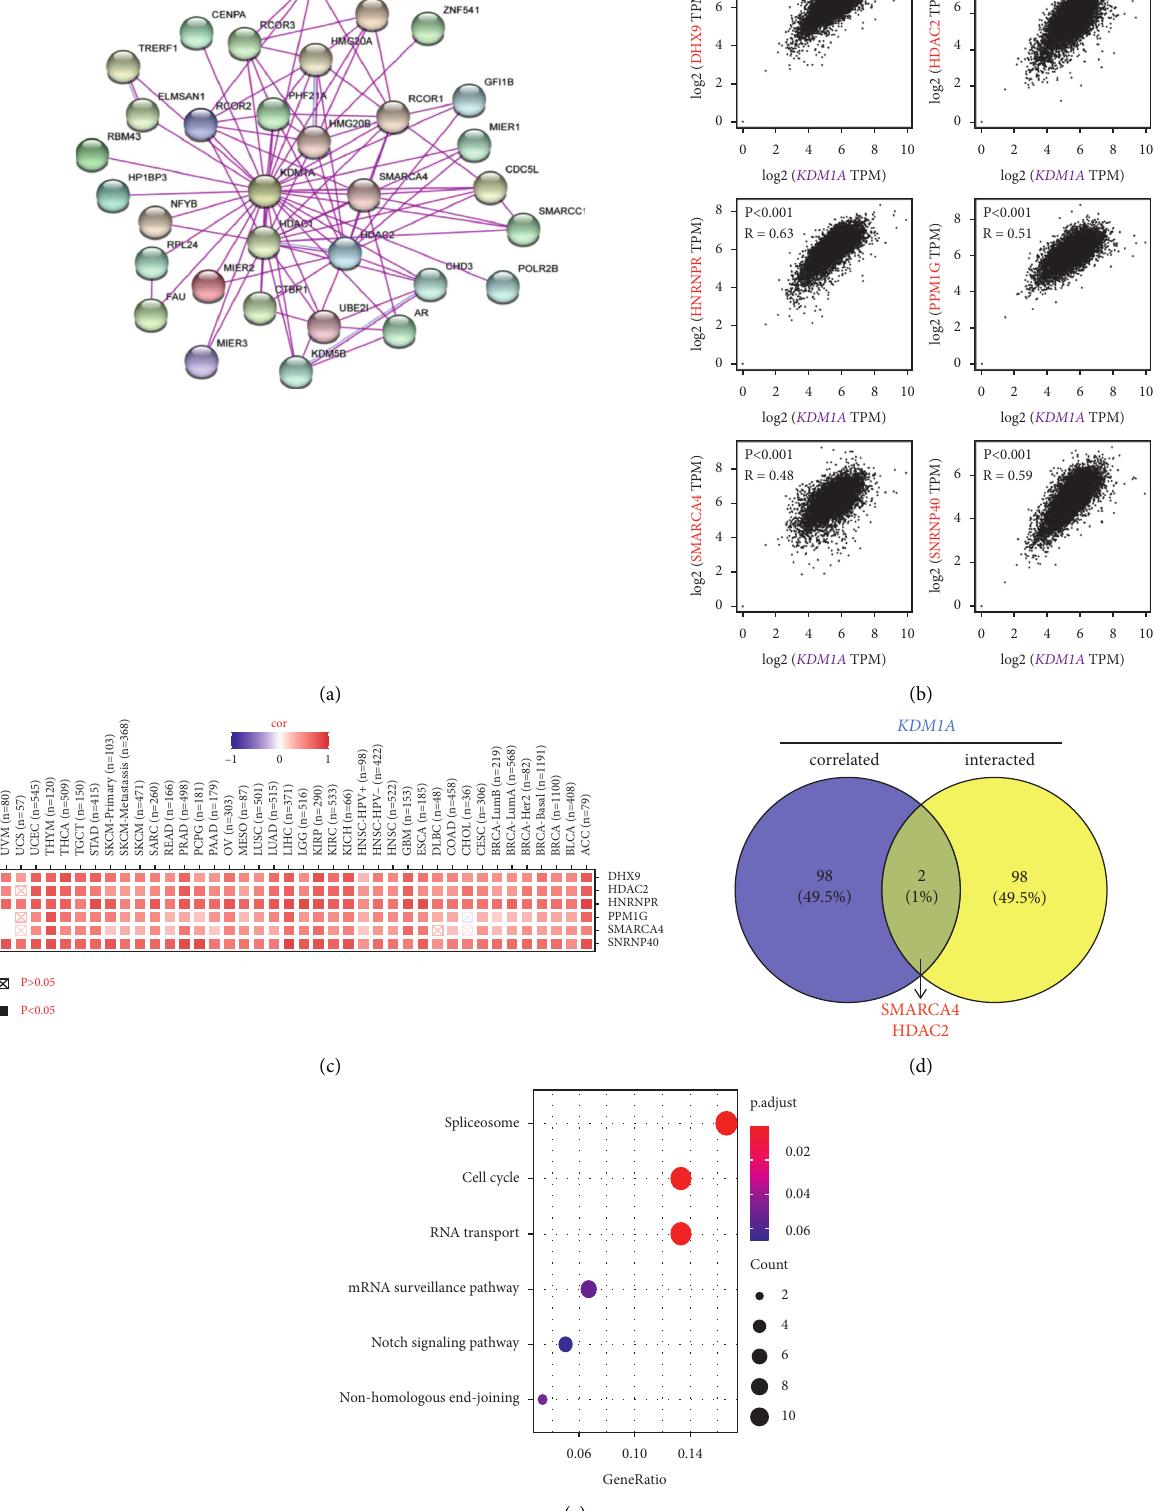
Figure 6: KDM1A-related gene enrichment analysis. (a) KDM1A-binding proteins were determined using the STRING tool. (b) The correlation of KDM1A and 6 top targeting genes was analyzed by GEPIA2. (c) The heatmap showed a corresponding relationship in the detailed cancer types. (d) An intersection analysis was conducted with the KDM1A-binding and correlated genes. (e) The bubble plot displayed KEGG pathway analysis based on the KDM1A-binding and interacted